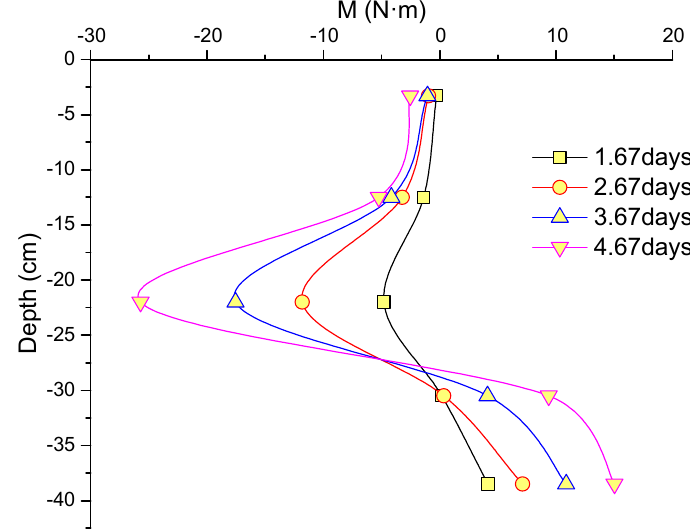
Figure 9. Distribution of the bending moment along the pile at different times.